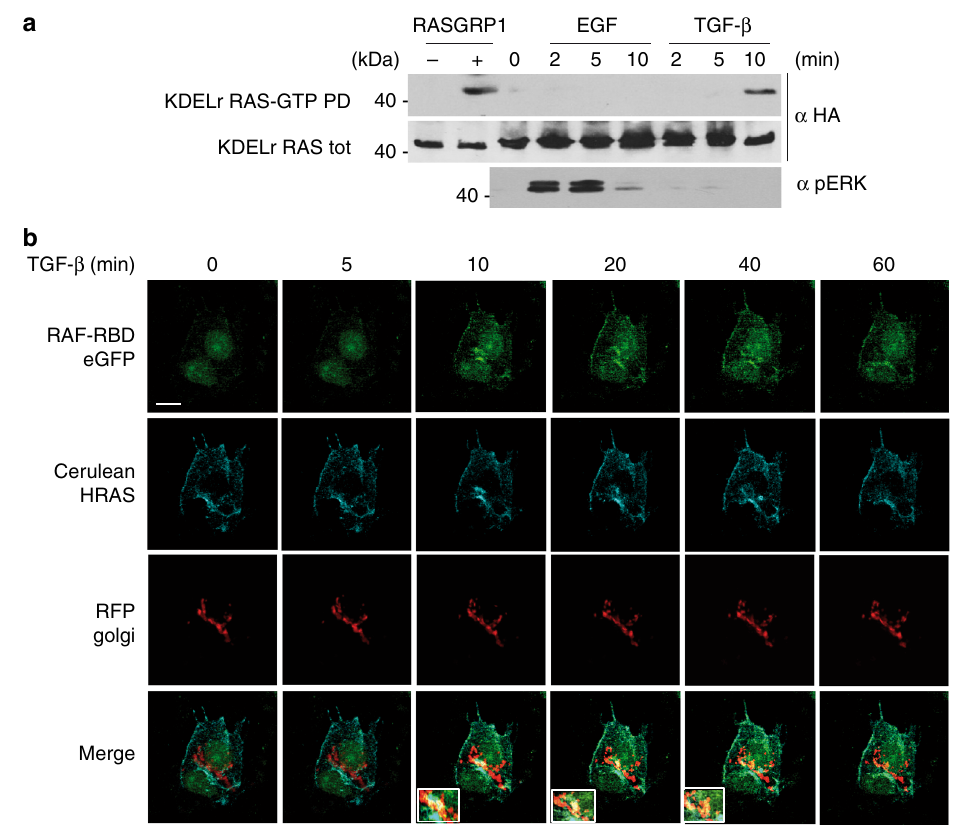
Fig. 2 GC RAS response to apoptogenic stimuli. a Apoptogenic stimuli activate RAS at the GC. MCF-7 cells transfected with HA-tagged KDELr HRAS (0.5 μ g), unstimulated (0) or treated with TGF- β (5 ng/ml) for the indicated times. Cells transfected with RASGRP1 (1 μ g) ( + ) serve as positive control. GTP loading was assayed by GST-RBD pull-down (RAS-GTP-PD). b RAS activation in endomembranes induced by TGF- β . MCF-7 cells transfected with constructs expressing cerulean-HRAS and the RAS-GTP biosensor E3-R3 (RAF-RBD) (1 μ g each) and stimulated for the indicated times. GC was revealed by the RFP Golgi probe. Insets show areas of prominent RAS-GTP accumulation. Scale bar = 10 μ m. See also Supplementary Fig.